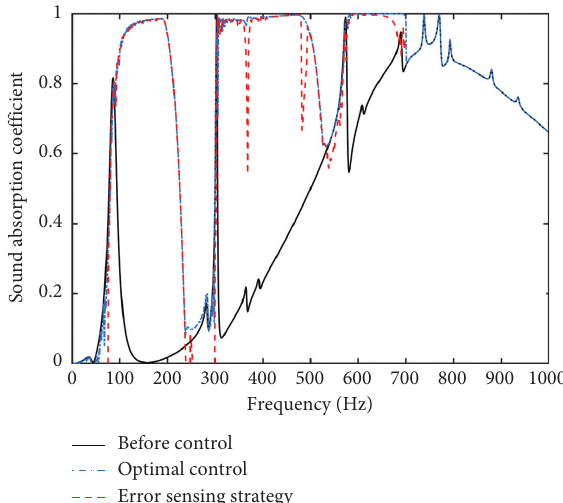
Figure 11: Active control results for the case of panel dimension being 0.2 m ×